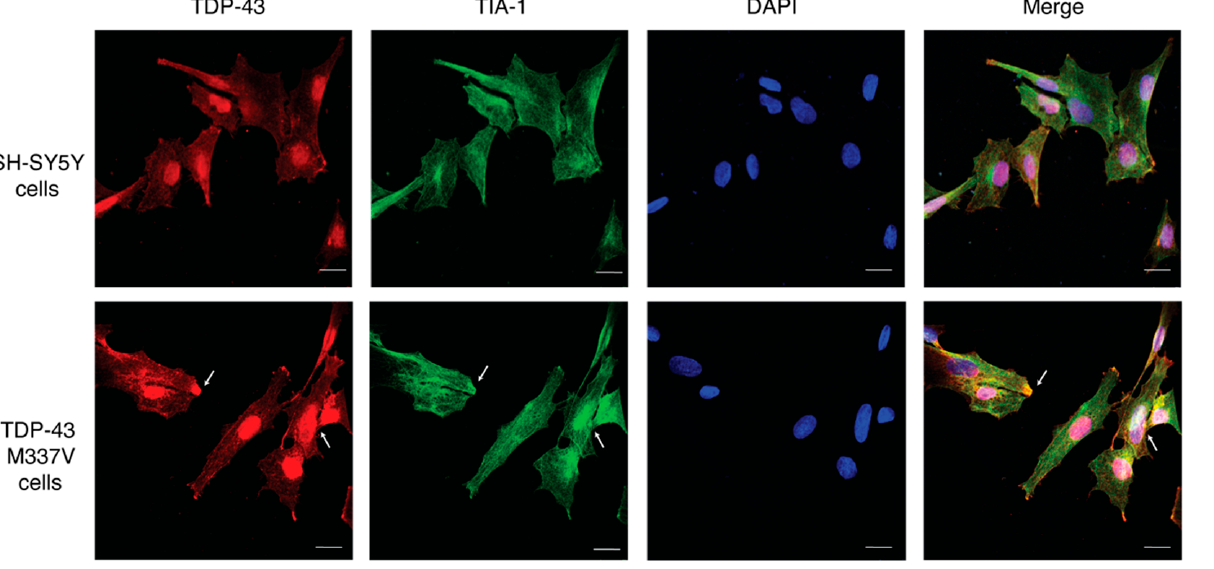
Figure 4. Comparing TDP-43 distribution in human neuroblastoma SH-SY5Y cells stably transfected with TDP-43 M337V mutant (V5-tagged) compared to WT SH-SY5Y cells using Western blots. ( A , B ) Cytoplasmic and nuclear TDP-43 expression of SH-SY5Y WT cells compared to transfected SH-SY5Y TDP-43 M337V. ( C , D ) Relative RIPA-soluble and urea-soluble expression levels of TDP-43 WT in SH-SY5Y cells compared to TDP-43 M337V mutant. Data represent mean ± SD, n ≥ 3, statistical analysis using parametric, unpaired t -test. * p < 0.05, *** p < 0.001.